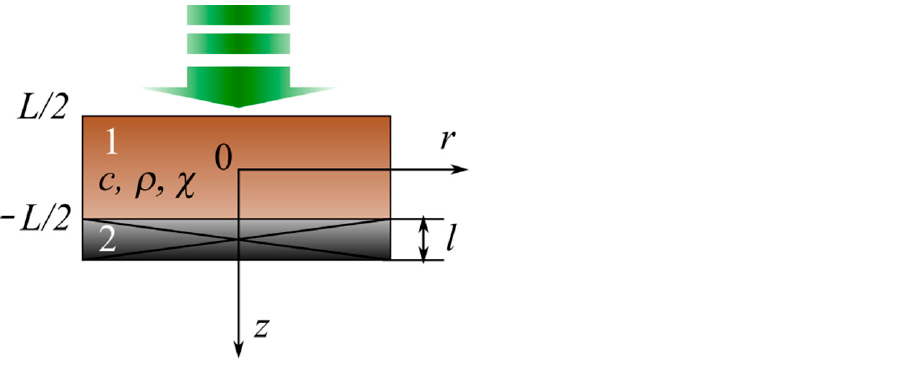
Figure 7. Schematic representation of the structure used to study the parameters of a photoacoustic response in piezoelectric registration.